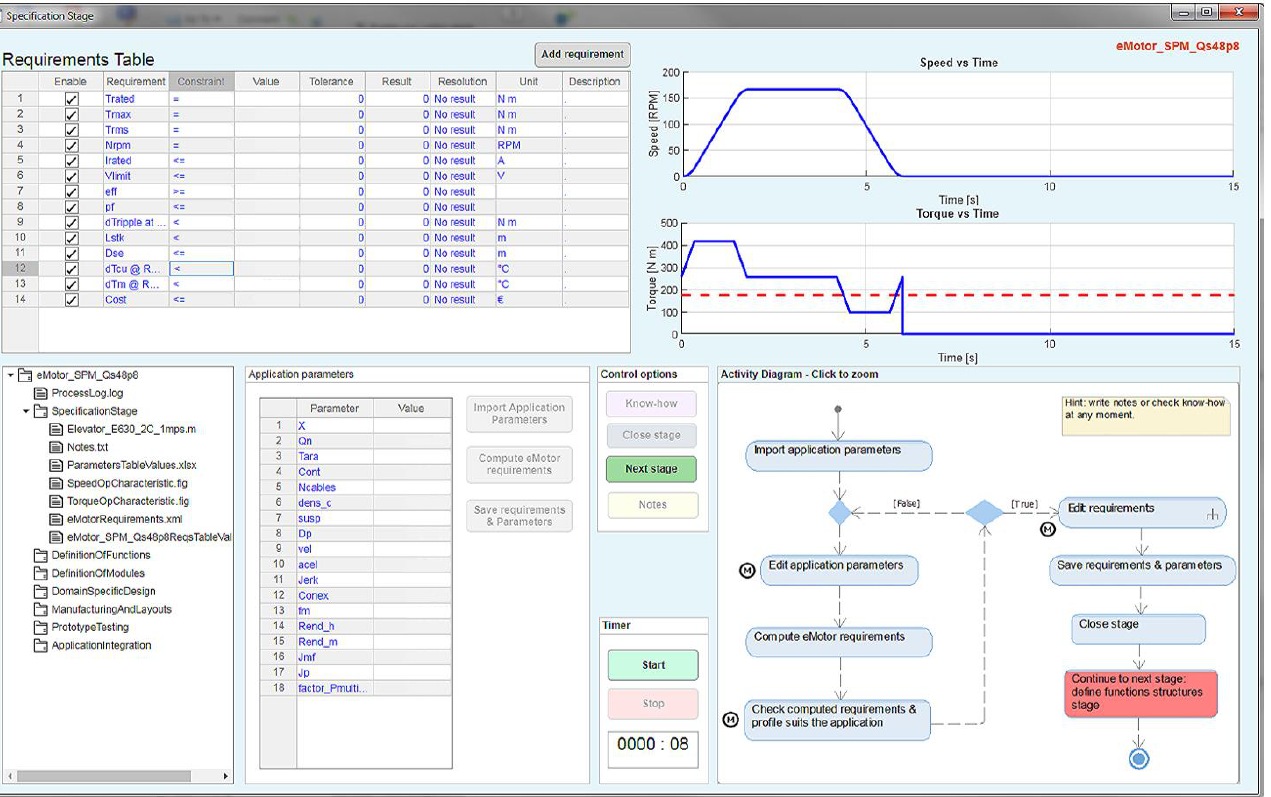
Figure 13. User interface for the specification stage of the KBE application.